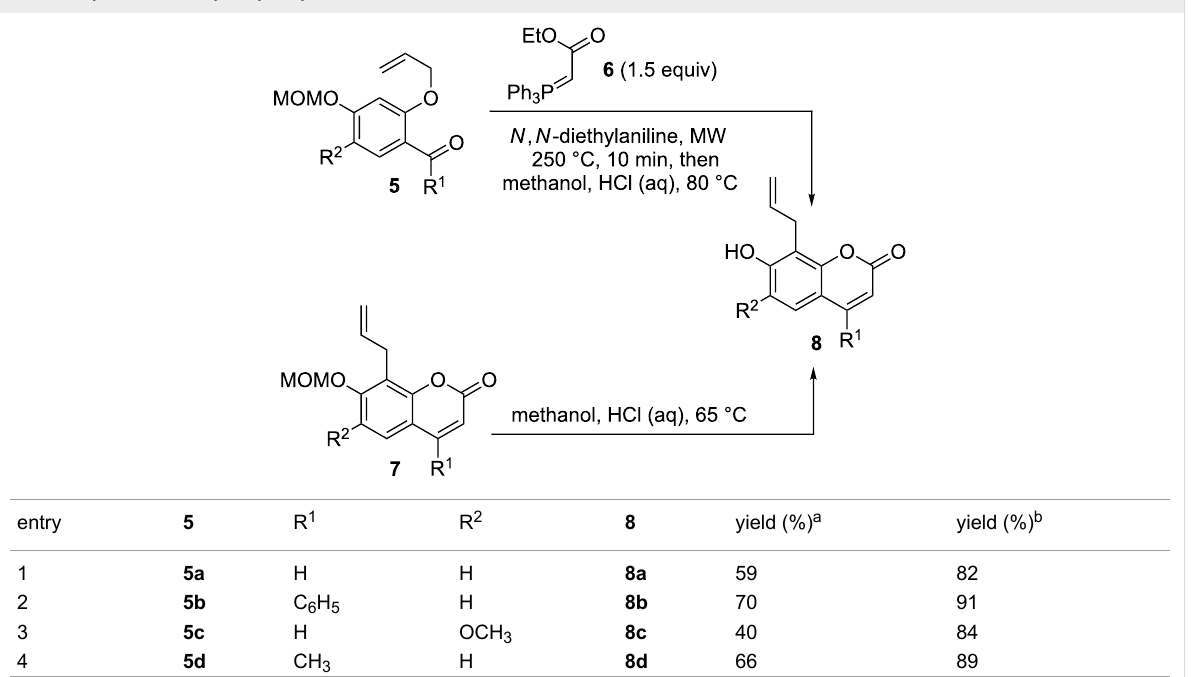
Table 1: Synthesis of 8-allyl-7-hydroxycoumarins 8